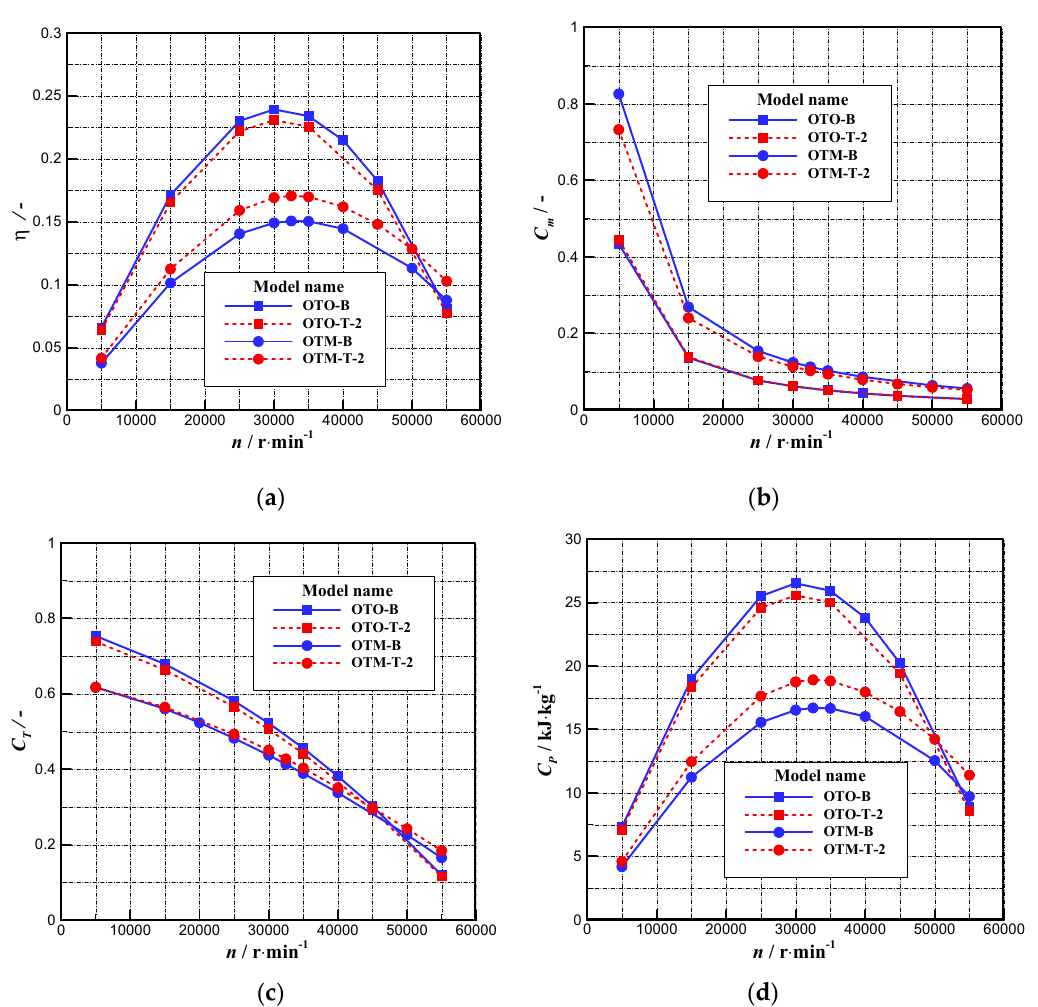
Figure 7. Aerodynamic performance comparison of the turbine models with sharp disc tips and blunt disc tips for both the one-to-one turbine and the one-to-many turbine. ( a ) Isentropic efficiency; ( b ) flow coefficient; ( c ) torque coefficient; ( d ) specific